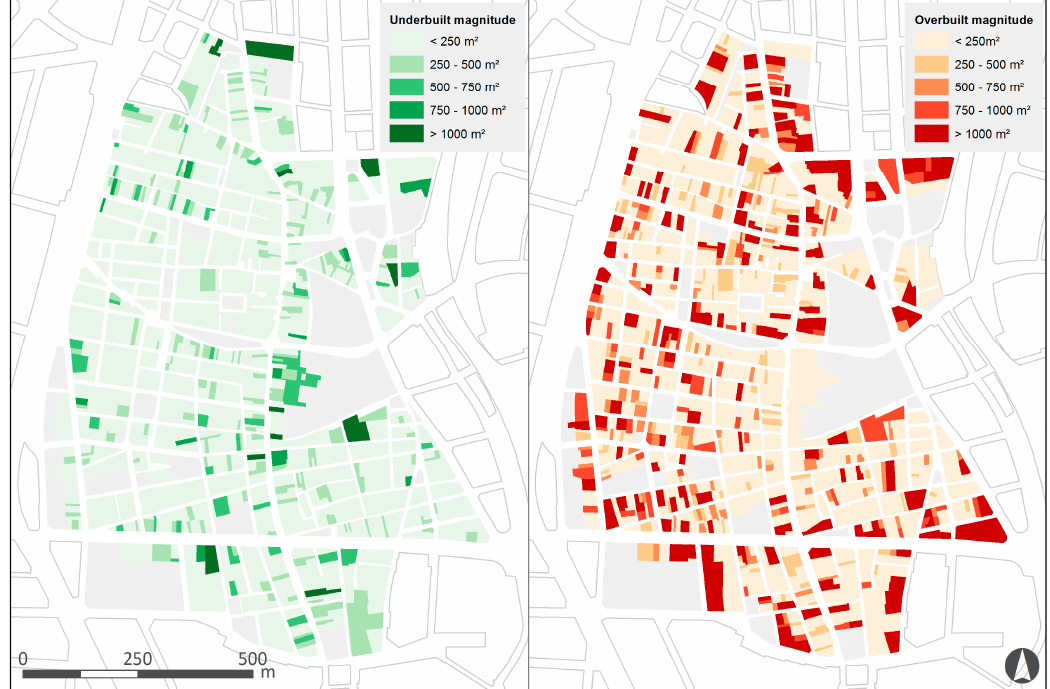
Figure 11. Map of amount of underbuilt ( left ) and overbuilt ( right ) area per